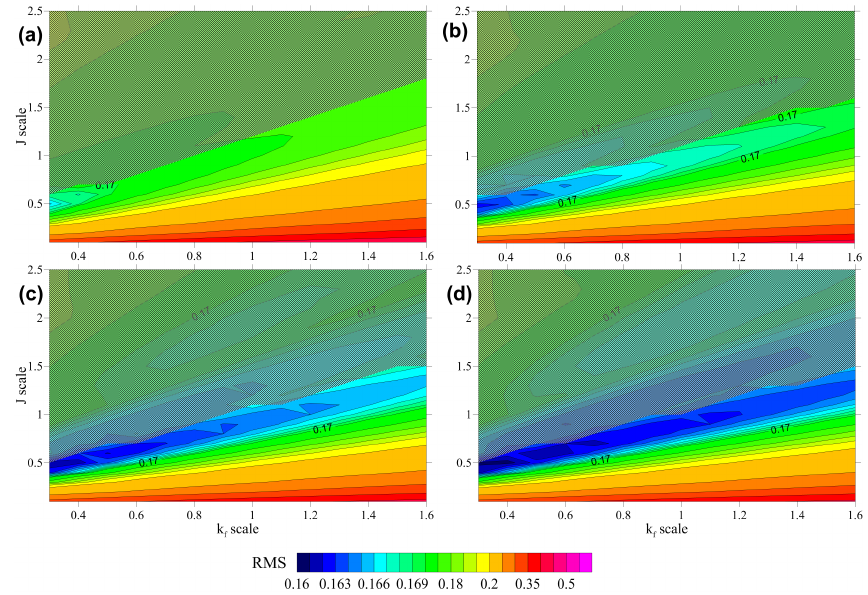
Fig. 3. Scale factors for J and k f with the corresponding RMS minimum derived from exploring the parameter space by varying k f scale , J scale , K eq scale , and ClO x scale . The derived RMS minimum values are shown for prescribed K eq scale of 0.4 (a) , K eq scale of 0.8 (b) , K eq scale of 1.2 (c) , and K eq scale of 1.6 (d) . The blue colour scale indicates the smallest RMS values (below 0.168), while RMS values greater than 0.2 are shown in orange/red colours. The dark, hatched area towards the top left of the panels shows the RMS values where the ClO x scale factor was not equal to 1 (for details see text).